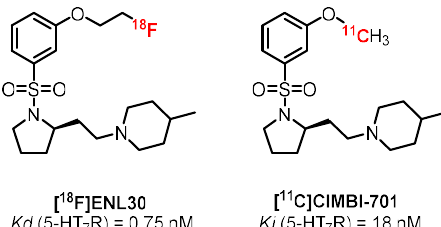
Figure 20. [ 18 F]ENL30 and [ 11 C]CIMBI-701 .